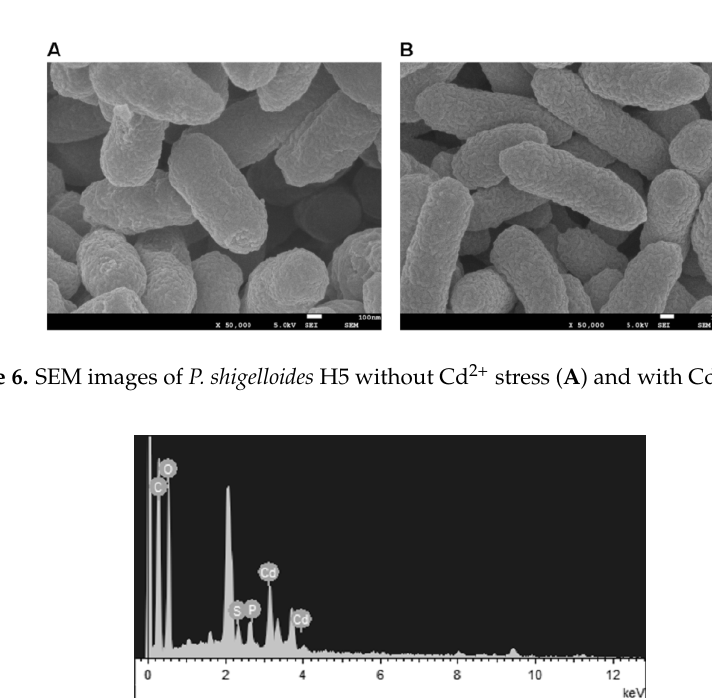
Figure 7. EDX image of P. shigelloides H5 with Cd 2+ stress.